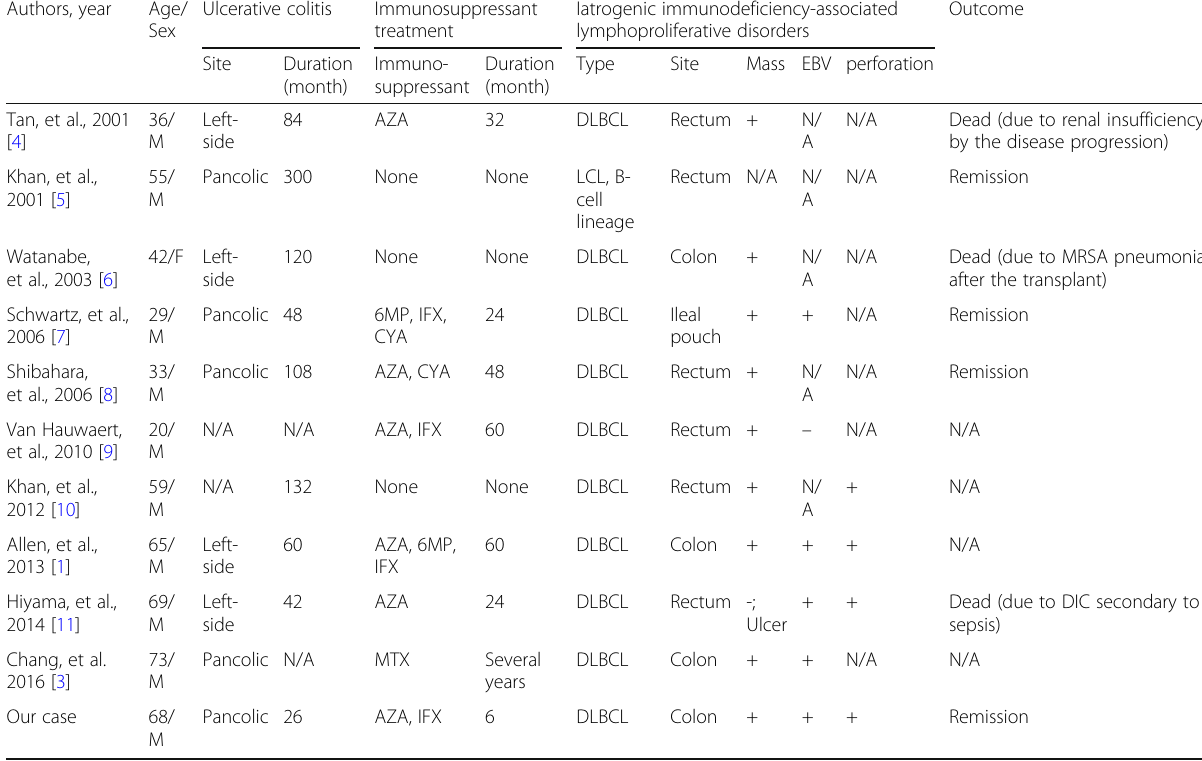
Table 1 Clinicopathological data of diffuse large B-cell lymphoma (DLBCL) complicating ulcerative colitis published in English literature from 2001 to